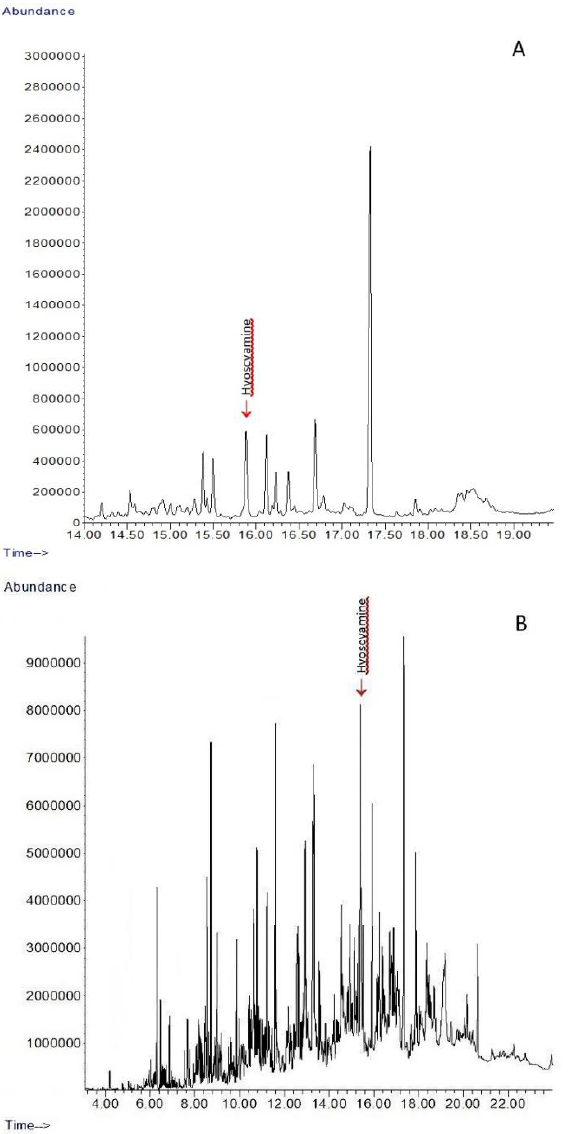
Figure 3. Chromatograms (detector response — abundance vs. retention times in min) obtained from the GC-MS analysis of D. stramonium extracts from roots. ( A ) Healthy control plants, ( B ) Plants elicited with ToMV SL-1. The peak representing hyoscyamine is indicated.